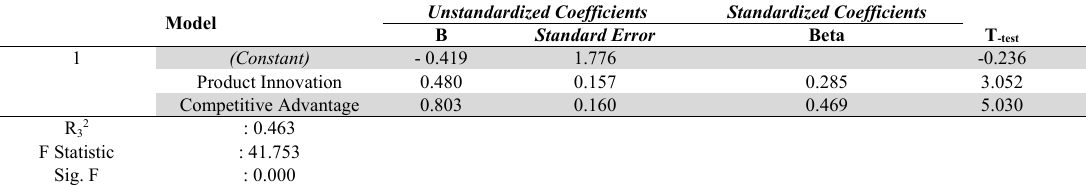
Analysis Results of Regression Equation Pathway